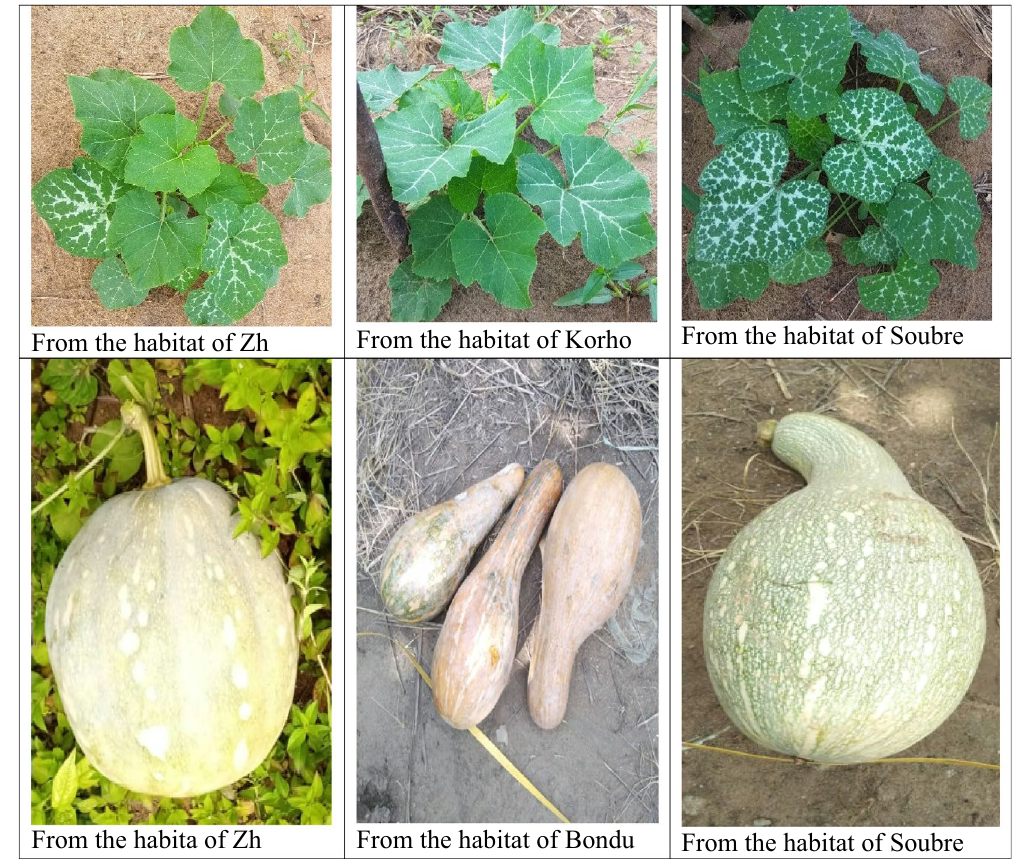
Figure 5. Seedlings and fruits of C. moschata from some of the sampled